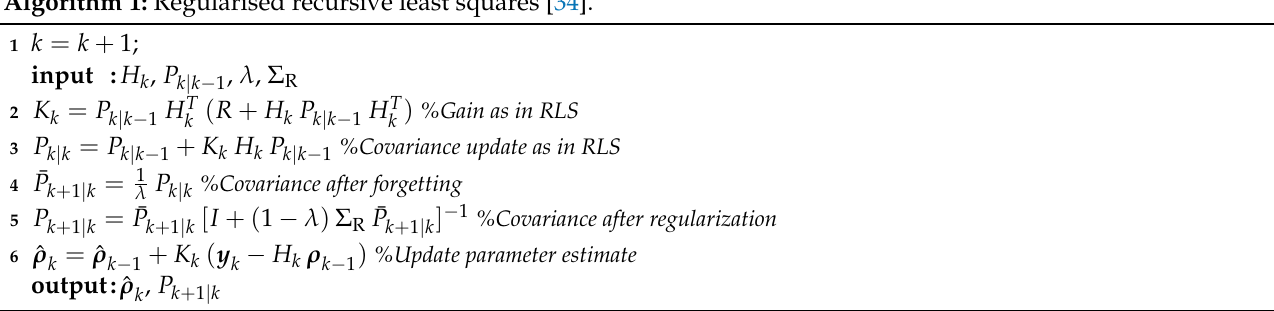
Algorithm 1: Regularised recursive least squares